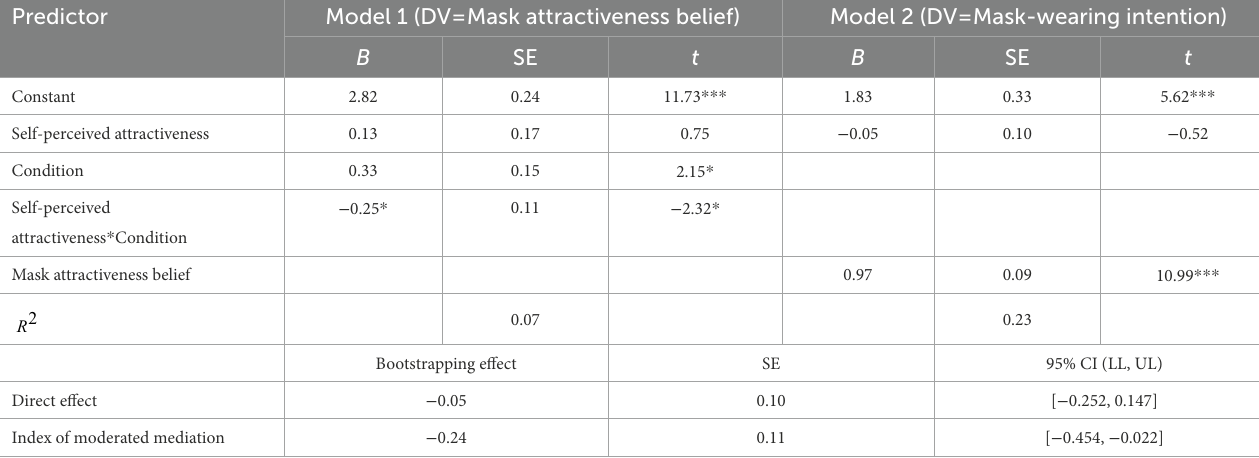
TABLE 3 Test of moderated mediation model in Study 3 ( N = 442).